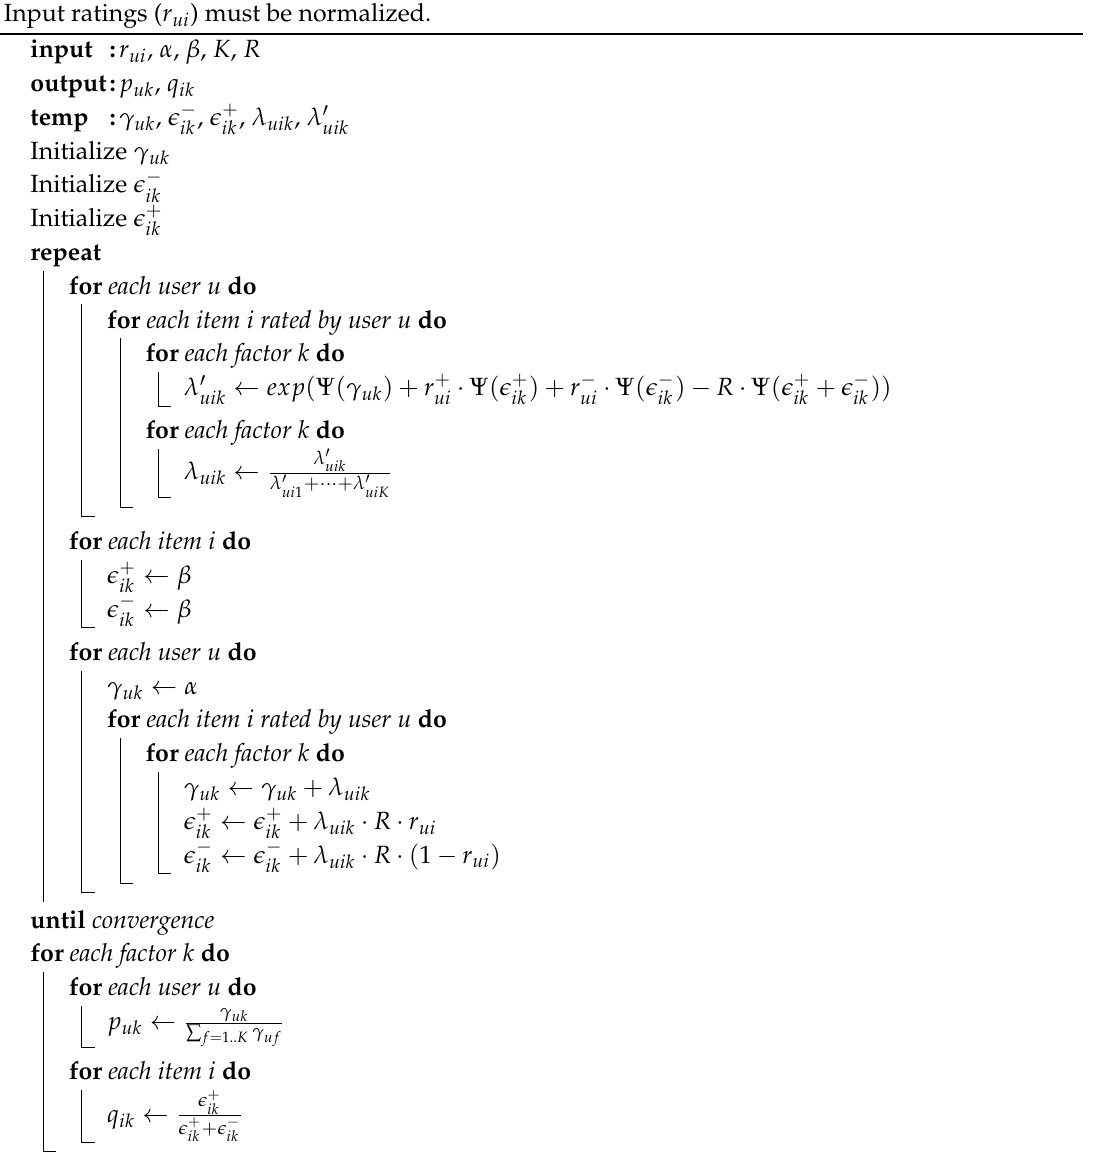
Algorithm 2: BNMF algorithm. The algorithm returns the latent factors for each user and item. Input ratings ( r ui ) must be